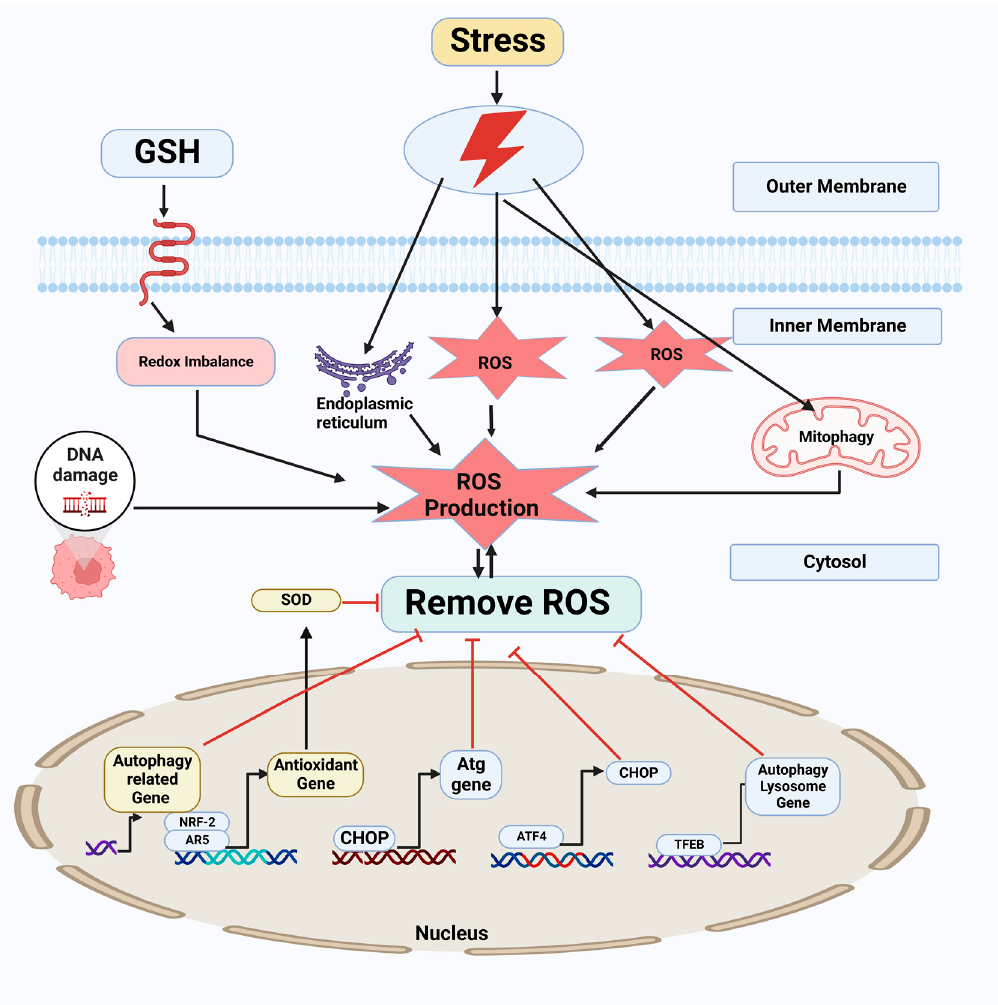
Figure 3. ROS homeostasis is regulated by autophagy. ROS facilitate autophagy by severing the connections of TFEB with RRAG GTPase and beclin 1 with Bcl2. ROS cause a conformational change in Keap1, ultimately resulting in the dissociation of the Keap1-Nrf2 complex, another mechanism through which ROS activate Nrf2. Therefore, cells can alleviate increased oxidative stress through the induction of autophagic activity and antioxidant proteins dependent on TFEB and Nrf2.